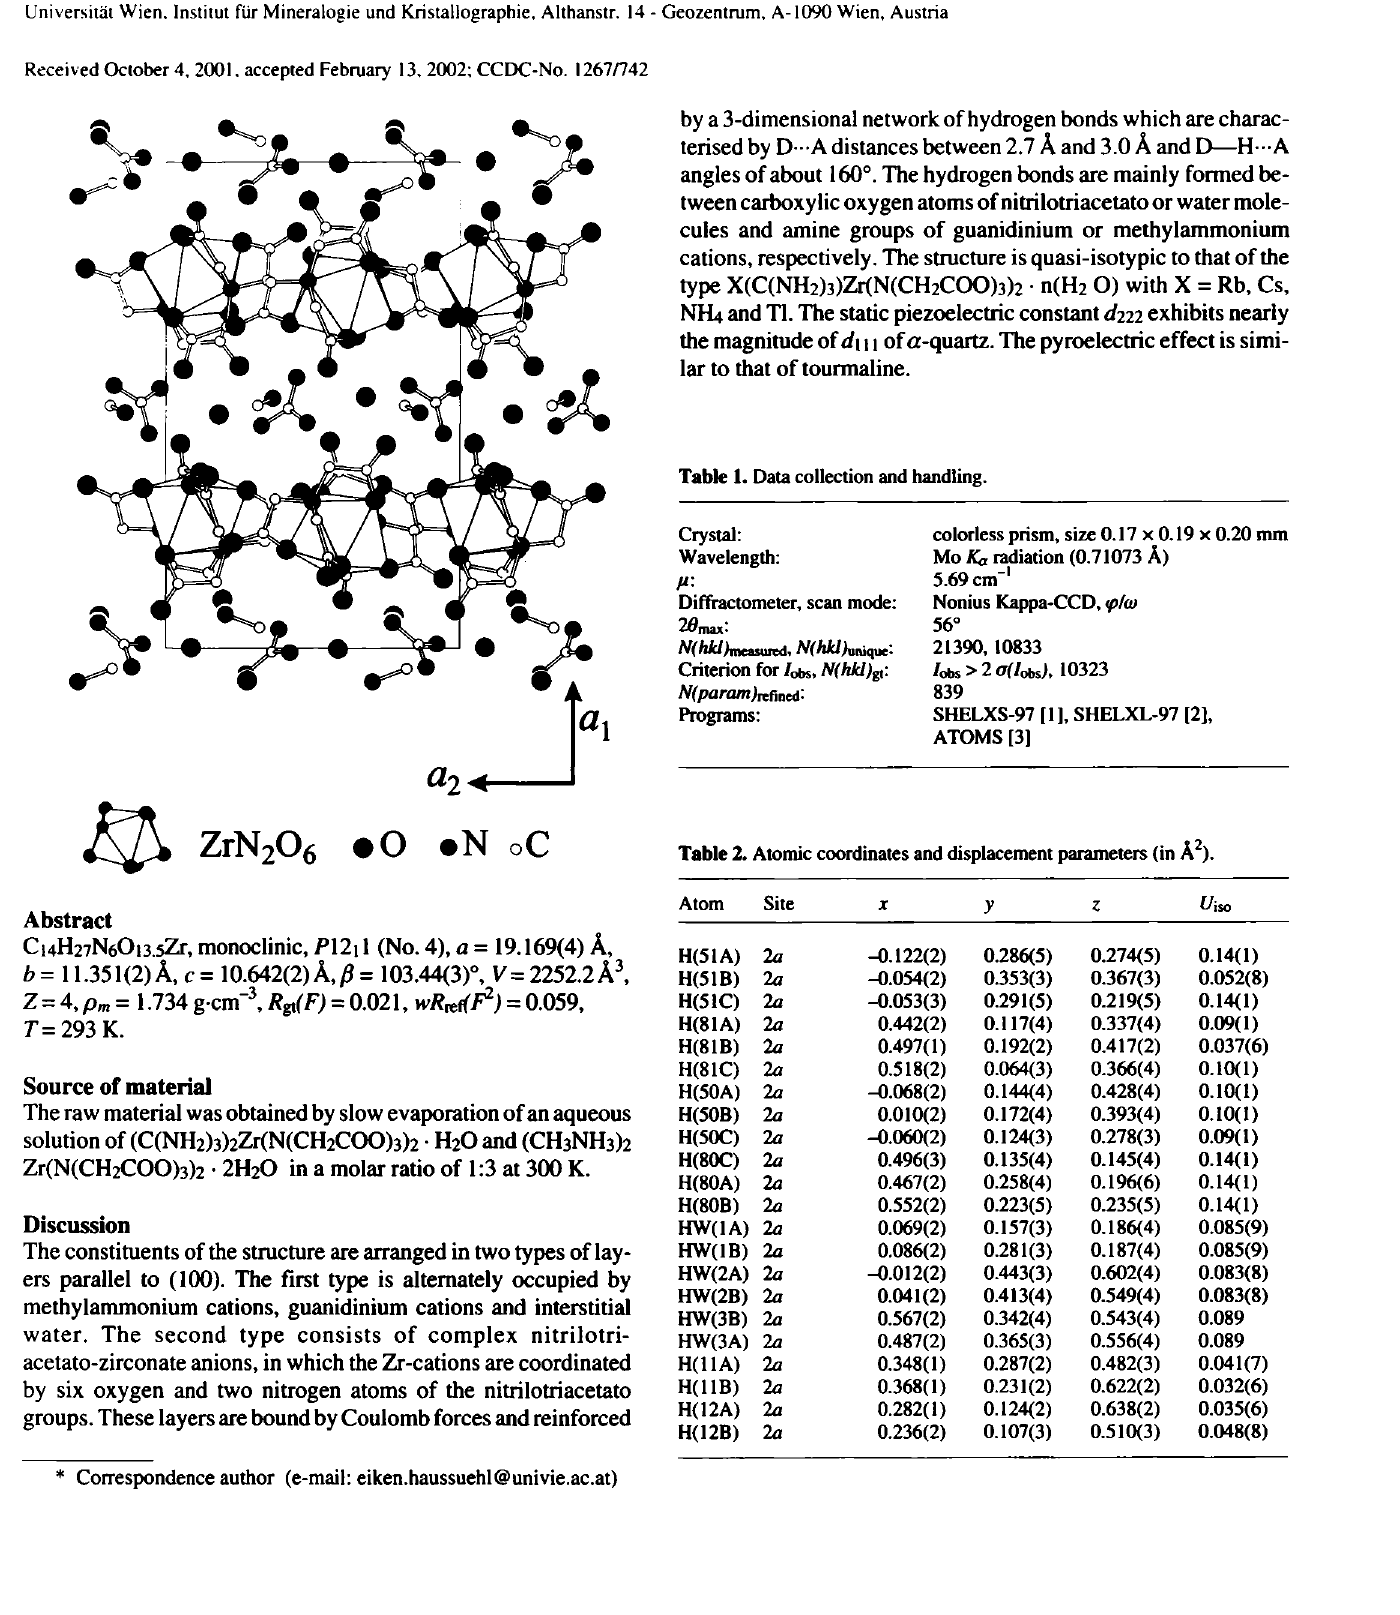
Table 1. Data collection and handling. Crystal: